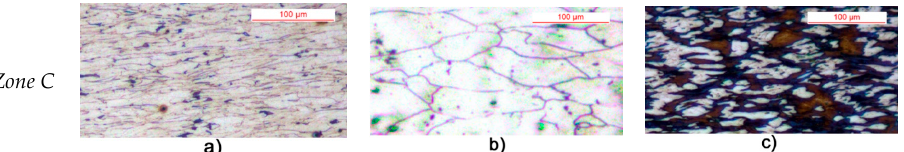
Figure 3. Microstructure of: ( a ) AISI 1005; ( b ) AISI 304L; and ( c ) DDS 2205, as a function of the analyzed zone (Figure 2c,d).